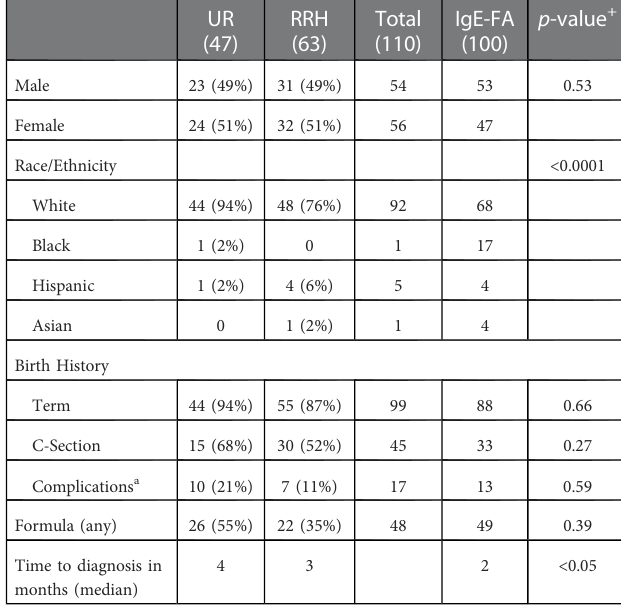
TABLE 1 Demographics and characteristics of the FPIES cohorts at university of Rochester medical center (UR) and Rochester regional health (RRH) and a control group (UR IgE-mediated food